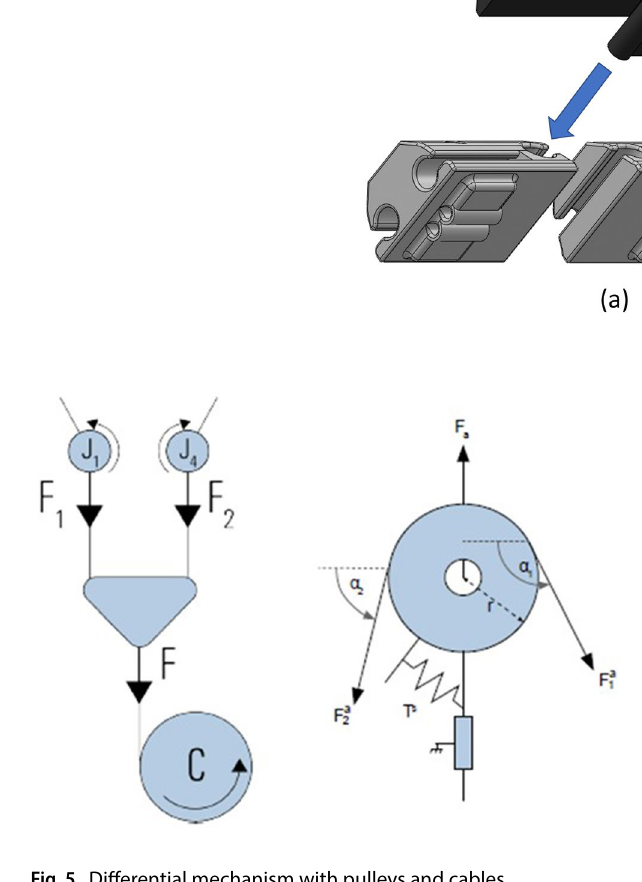
Fig. 4 Actuated scoop: a flex- ible component inserted into the slots of rigid modules; b scoop assembly